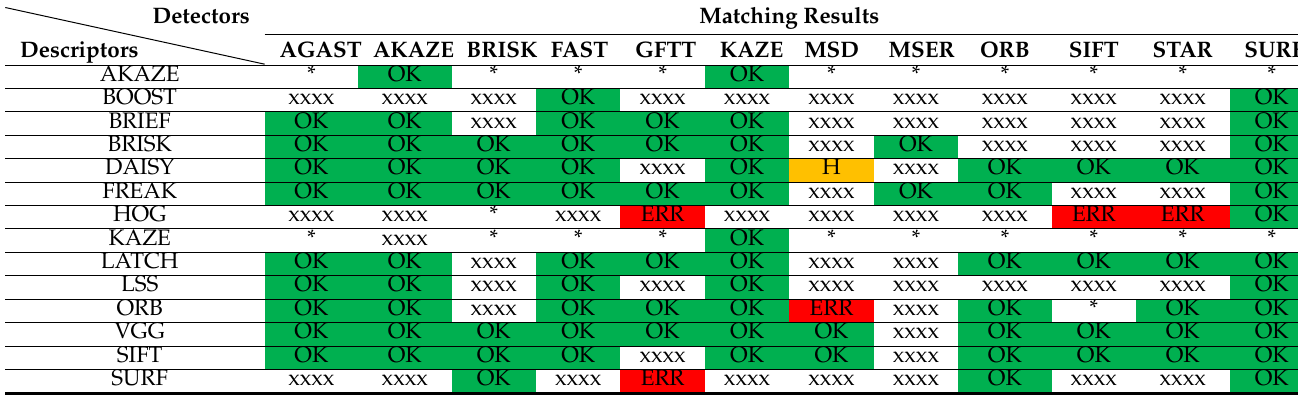
Table 7. The results of matching performed for four elevations. The description is performed according to Equation (10), and the “*” symbol means a descriptor not available, and the places where the “xxxx” symbol appears mean different results for different elevations. The abbreviations of detectors and descriptors are used as they were proposed by authors of these